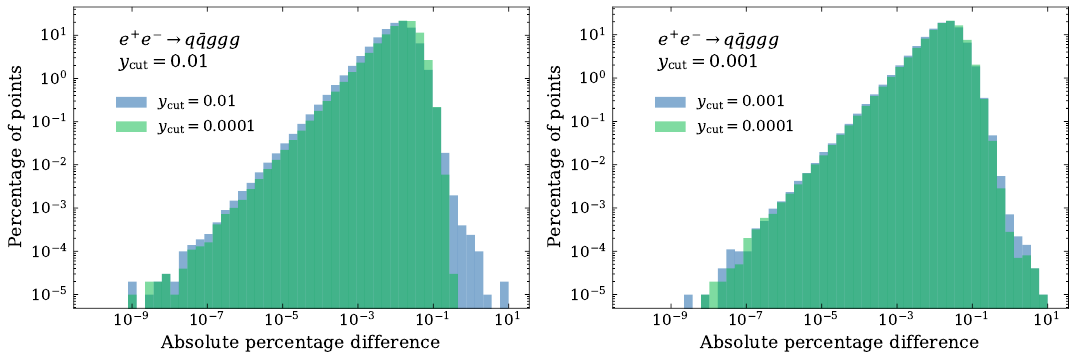
Figure 6 . Left: error distribution on the y cut = 0 . 01 testing dataset as predicted by y cut = 0 . 01 and y cut = 0 . 0001 models. Right: error distribution on the y cut = 0 . 001 testing dataset as predicted by y cut = 0 . 001 and y cut = 0 . 0001 models. We use a logarithmic vertical axis to highlight the right- hand tail of the error